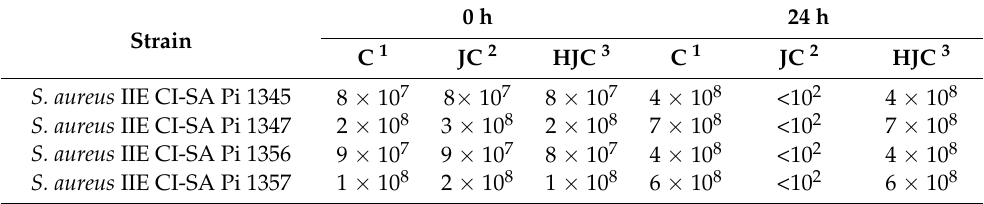
Table 4. Antagonistic activity of LF3872 against S. aureus isolated from the oropharynx of pigs. 0 Strain